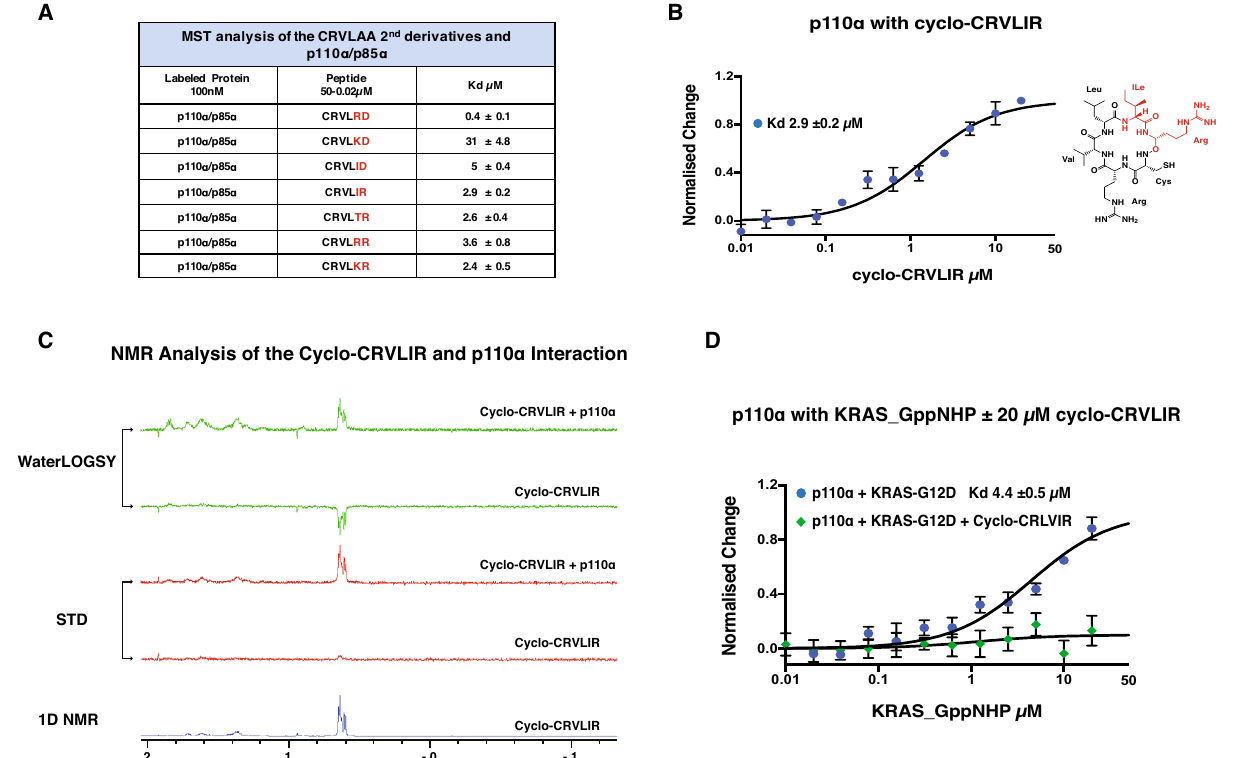
Figure 2. Characterisation of the 2nd cyclo-CRVLAA derivatives. ( A ) Table displaying the MST analysis of the 2nd cyclo-CRVLAA derivatives with p110α (p110α/p85α). ( B ) MST analysis of cyclo-CRLVIR with p110α (p110α/p85α). ( C ) NMR analysis of the interaction of cyclo-CRVLIR with 110α using WaterLOGSY and STD. ( D ) Competition assay using MST analysis of the p110α/KRAS interaction in the absence and presence of 20 µM cyclo-CRVLIR. p110α interacts with KRAS with an affinity of around K d 4.4 µM and this interaction is blocked by the addition of 20 µM